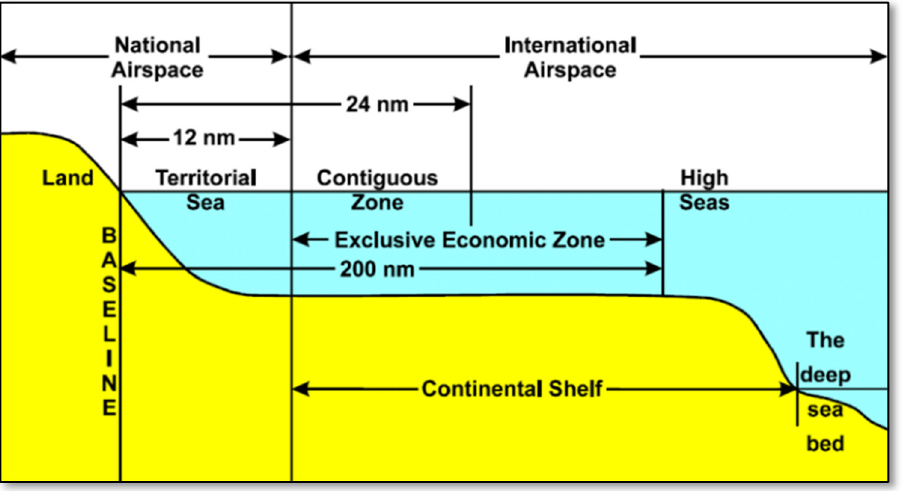
Figure 2. Maritime zones. Reproduced from footnote link (https://sites.tufts.edu/lawofthesea/chap- ter-two/ (accessed on 8 May 2022)), with permission of Tufts University. ter-two/ (accessed on 8 May 2022)), with permission of Tufts